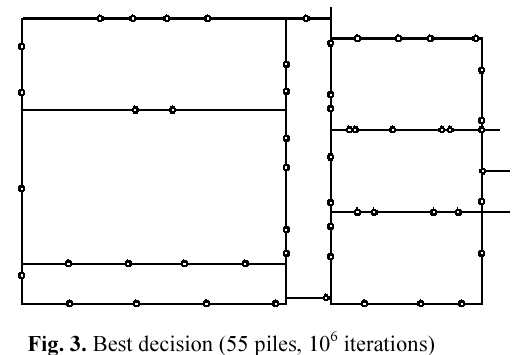
Fig. 3. Best decision (55 piles, 10